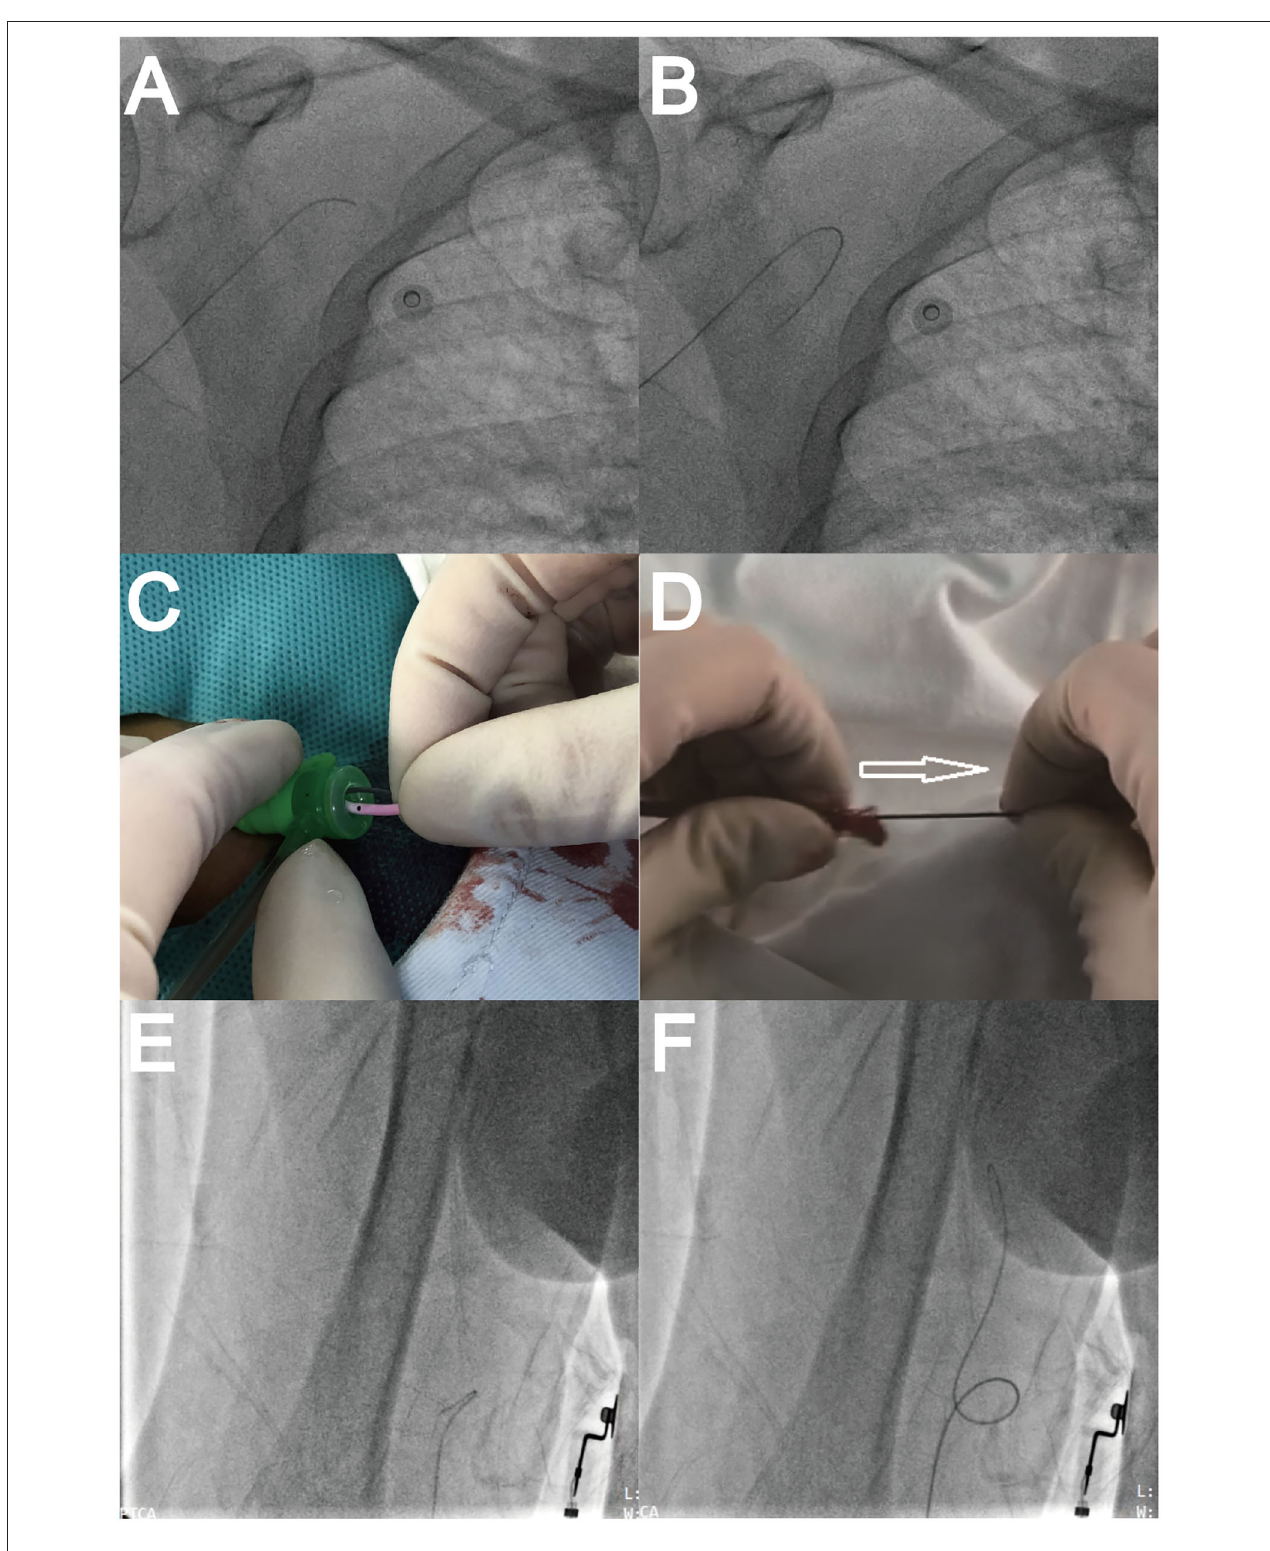
FIGURE 1 | Guidewire performances. (A) Guidewire advancement. (B) Guidewire slipping into a branch artery. (C) Inserting 5F Tiger catheter and protruding guidewire for knuckle use. (D) Fixing guidewire tail and pulling back the catheter to loosen guidewire. (E) Knuckle guidewire advancement. (F) Passing artery loop.